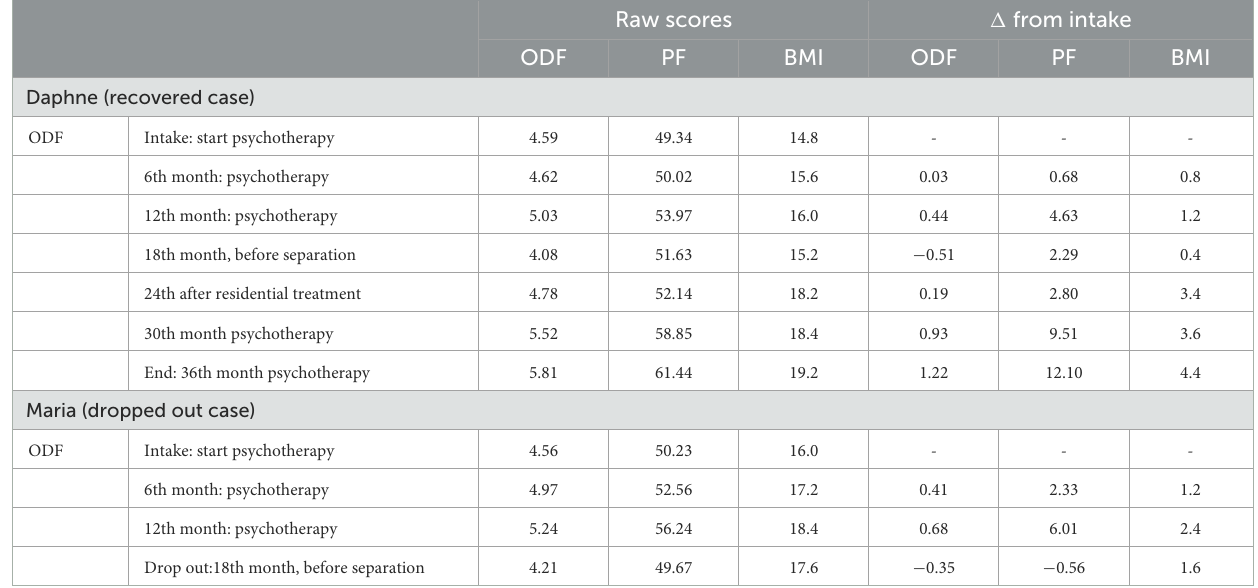
TABLE 1 Descriptive statistics of changes in ODF, PF, and BMI over the course of psychotherapy.